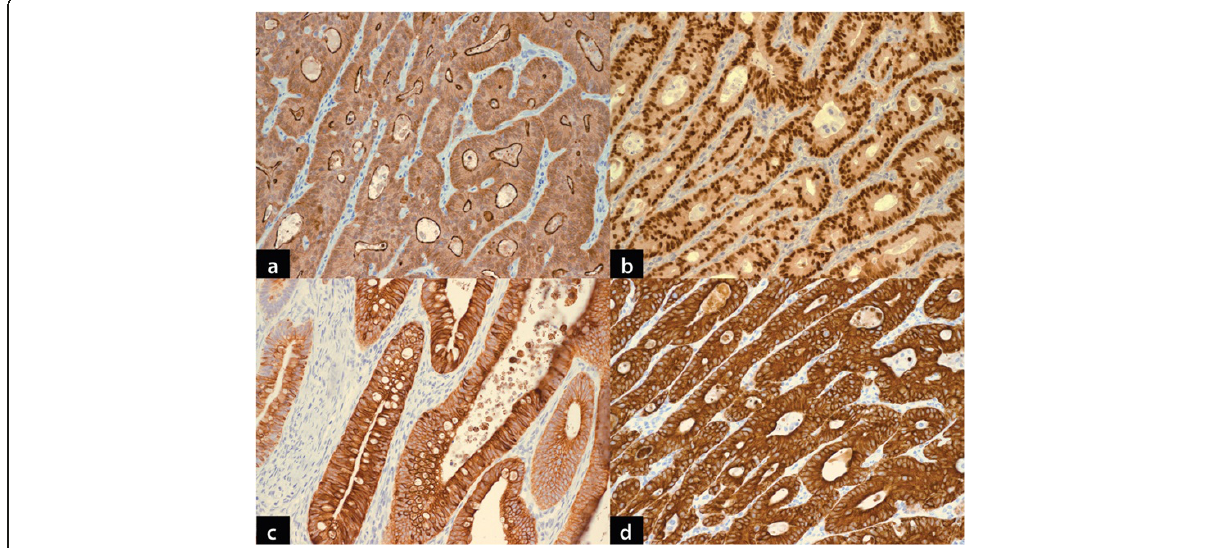
Figure 3 a: Primary bladder adenocarcinoma demonstrating apical brush border staining with villin . Very similar staining pattern was also seen in metastatic colorectal adenocarcinoma. (DAB chromogen, x100). b : Primary bladder adenocarcinoma demonstrating strong diffuse nuclear staining with CDX-2. Metastatic colorectal adenocarcinoma demonstrated same staining pattern. (DAB chromogen, x100). c : Primary bladder adenocarcinoma shows strong cytoplasmic staining with CK7. Overall, it was infrequently seen in glandular bladder tumors, however slightly more frequently in primary than metastatic adenocarcinomas. (DAB chromogen, x100). d : Primary bladder adenocarcinoma shows diffuse strong cytoplasmic positivity for CK20. This was also seen in majority of metastatic colorectal adenocarcinoma. (DAB chromogen,